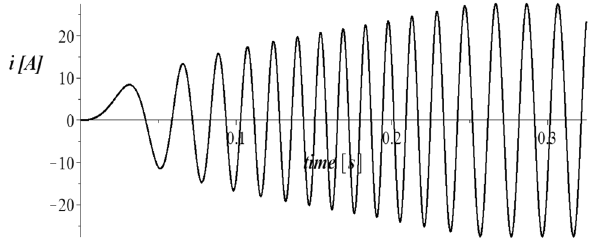
Fig. 6 Electric current in R,L circuit for sinusoidal shape of voltage frequency increase